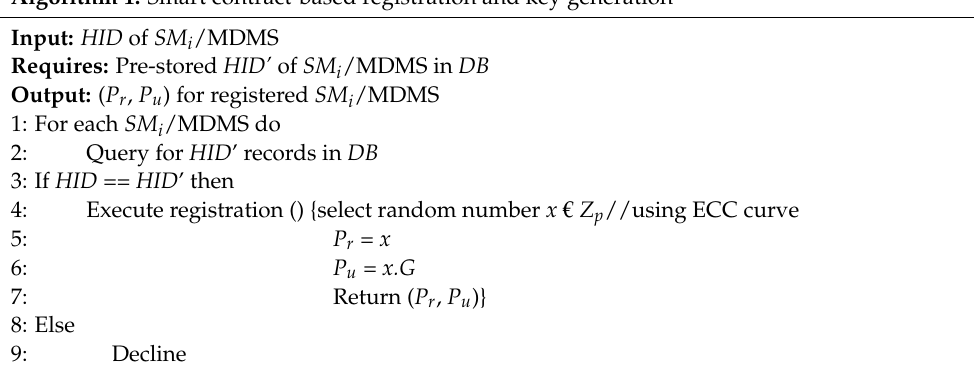
Algorithm 1: Smart contract-based registration and key